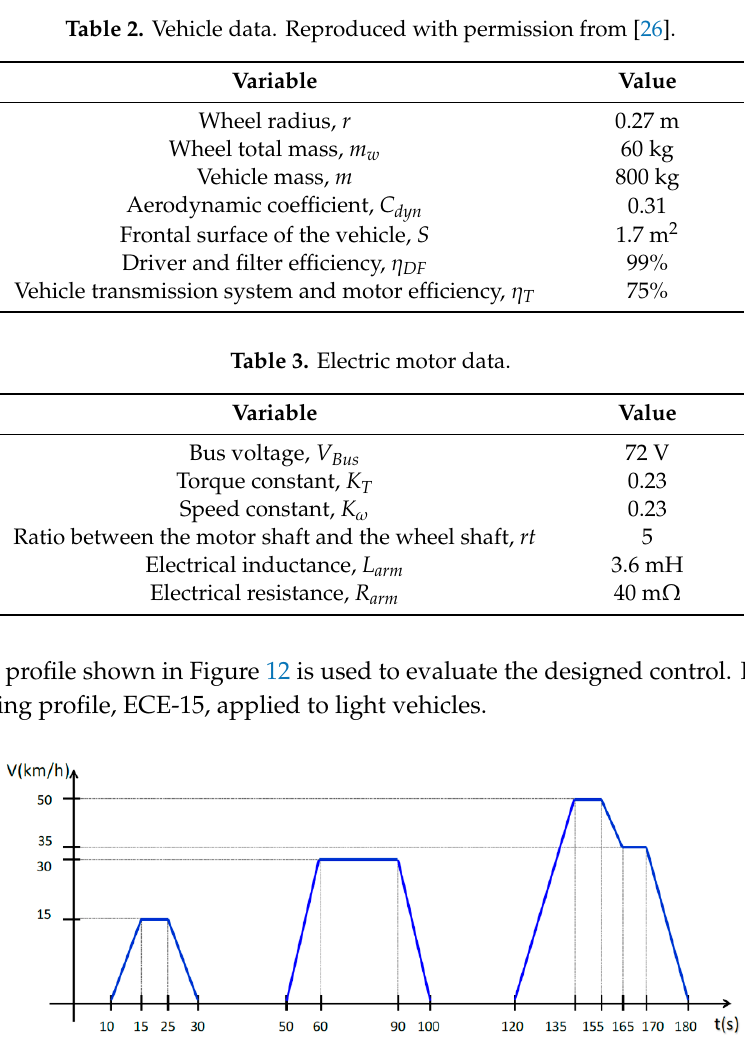
Table 2. Vehicle data. Reproduced with permission from [26].